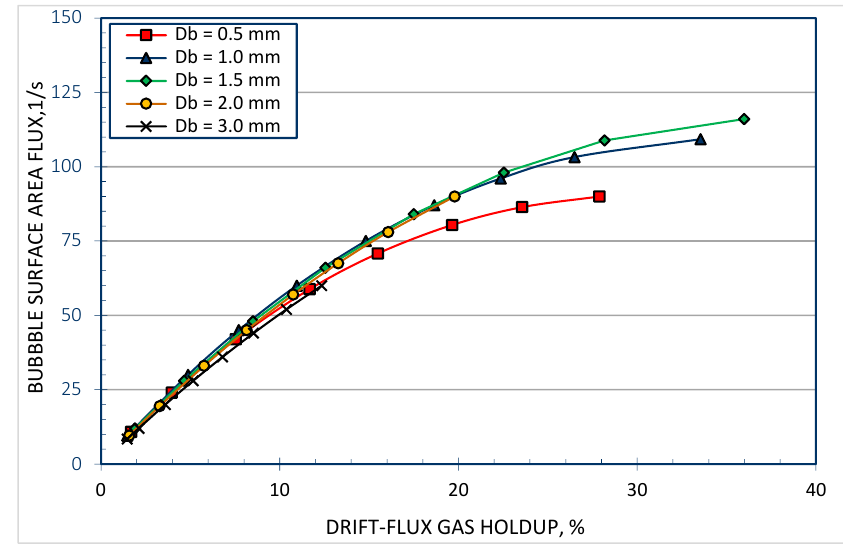
Figure 5. Bubble surface area flux vs. gas holdup prediction (drift-flux model).